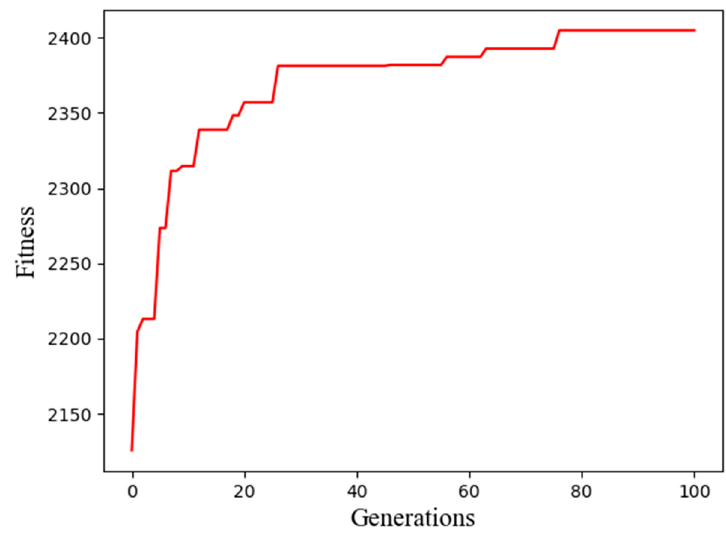
Figure 6. The generations and corresponding best fitness in Dataset 3.